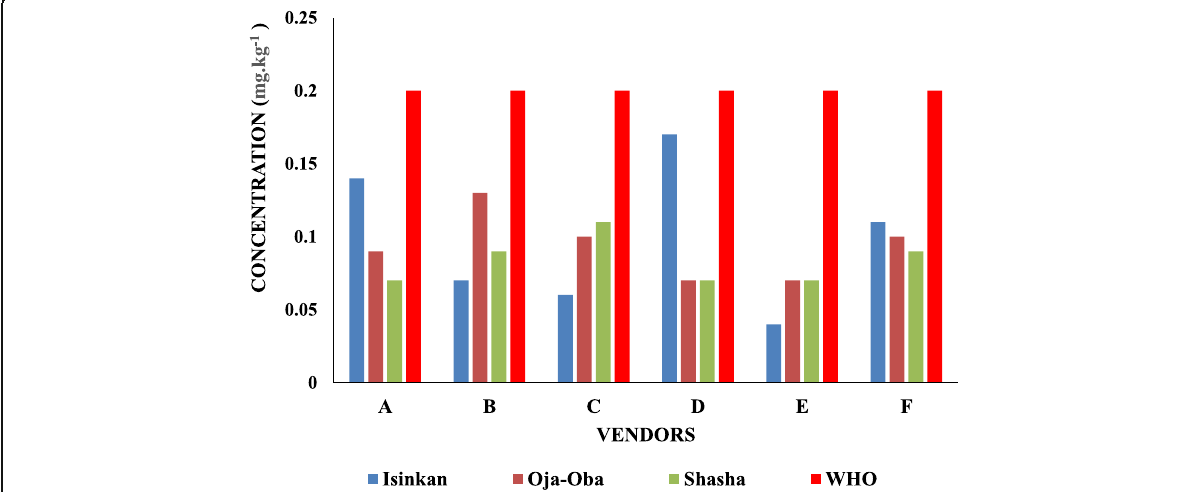
Fig. 2 Comparison of copper concentrations in the sliced watermelon fruits with WHO permissible